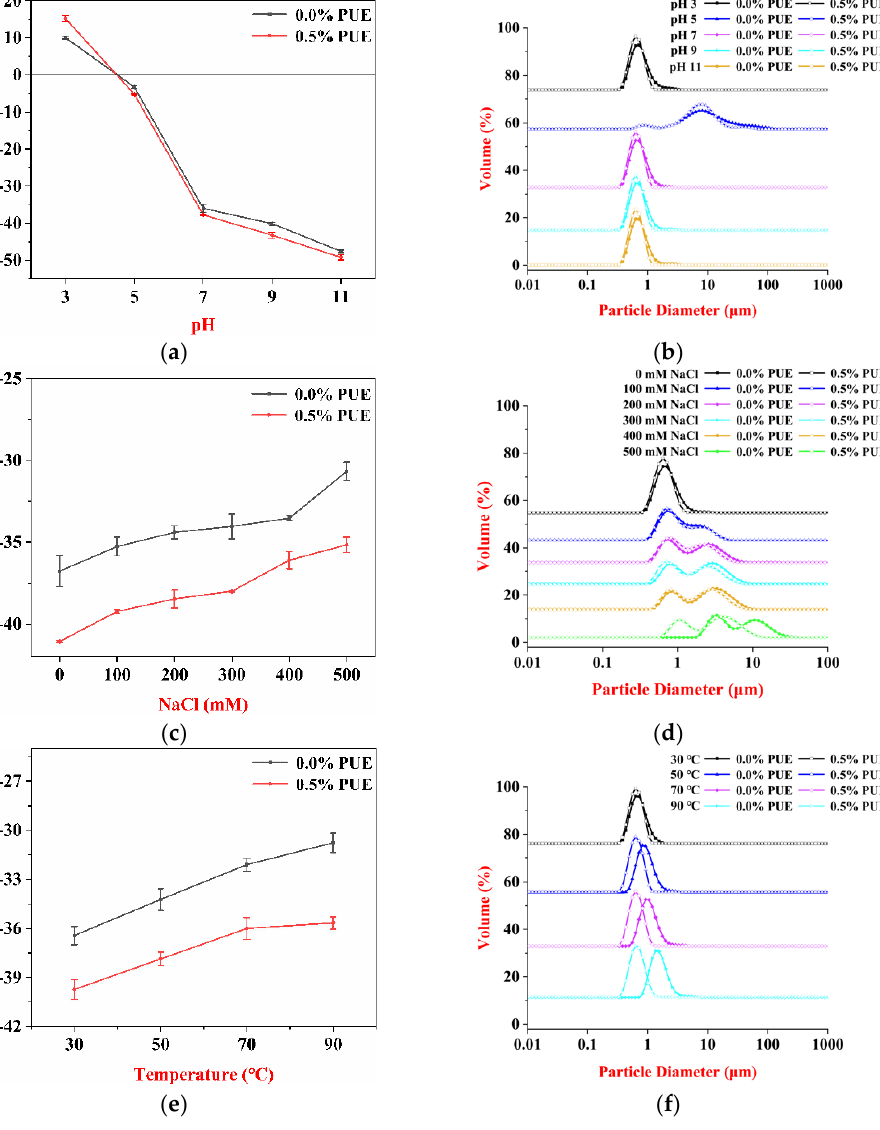
Figure 3. Impact of pH, ionic strength and thermal treatment on the emulsions stabilized by WPI only (0 PUE) or WPI–PUE composites (0.5% PUE). ( a, c , e ) ζ -potential and ( b , d , f ) particle size distribution.